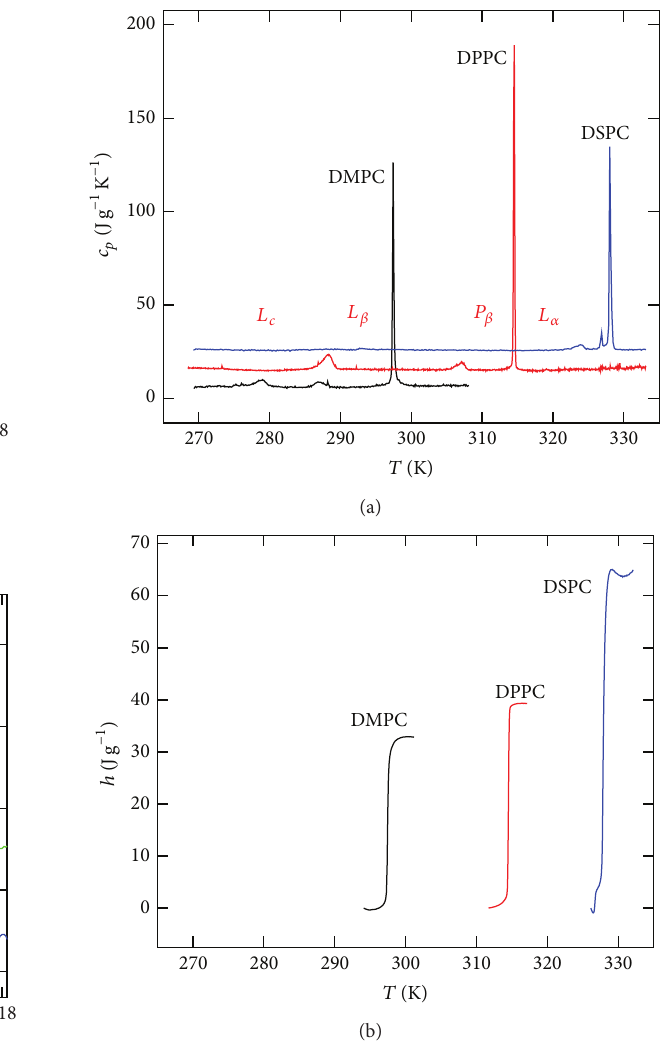
Figure 4: (a) Specific heat capacity 𝑐 𝑝 (𝑇) of the lipids in 10mgmL −1